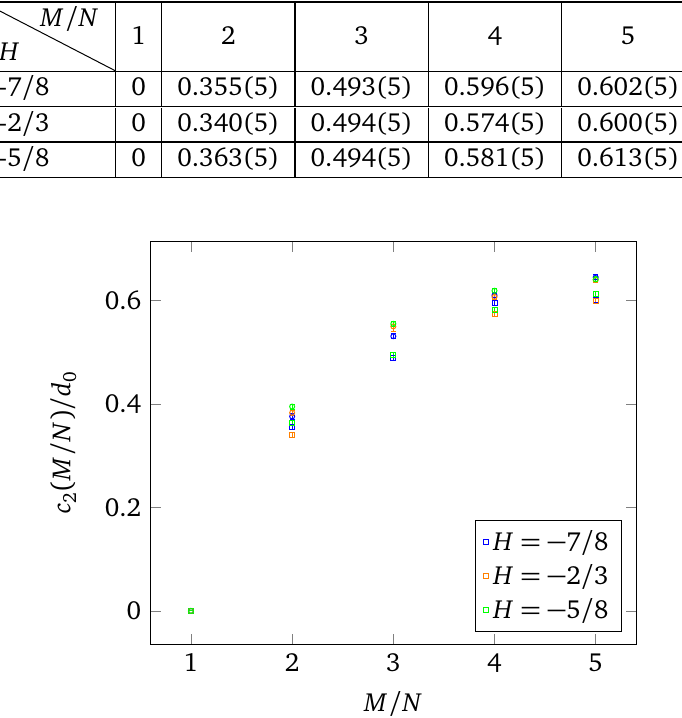
Figure 14: Comparison of the numerical values obtained for the universal quan- ( M / N ) / d tity c , for different Hurst exponents, for surfaces (48) (circles) and (52) 2 0